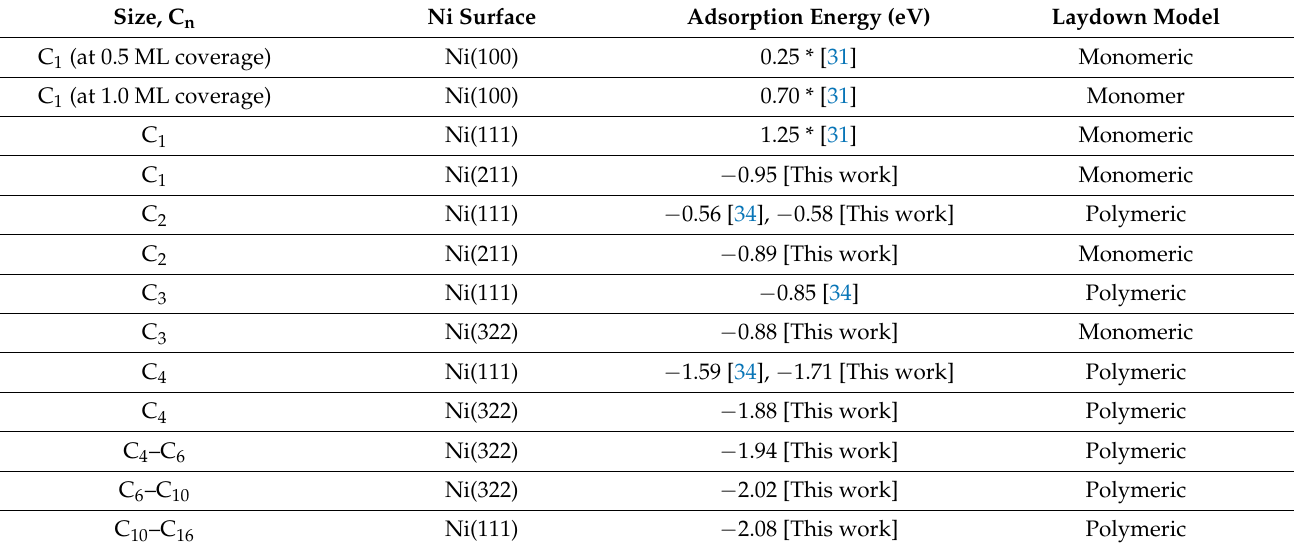
Table 1. Carbon cluster sizes and the corresponding adsorption energy in the laydown of carbon on different facets of the nickel surface. An asterisk (*) denotes adsorption energies that are obtained relative to a single carbon atom (C 1 ) that is inserted into an isolated infinite graphene layer